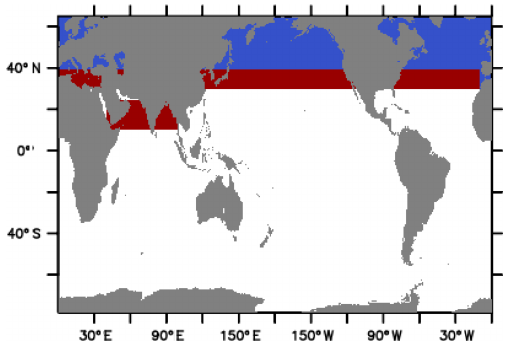
Figure 3. MOMSO domains where temperature and salinity are re- stored to observed climatological values (Locarnini et al., 2010; Antonov et al., 2009, respectively) throughout the water column. The red and blue patches denote e -folding restoring timescales of 10 and 5 years,